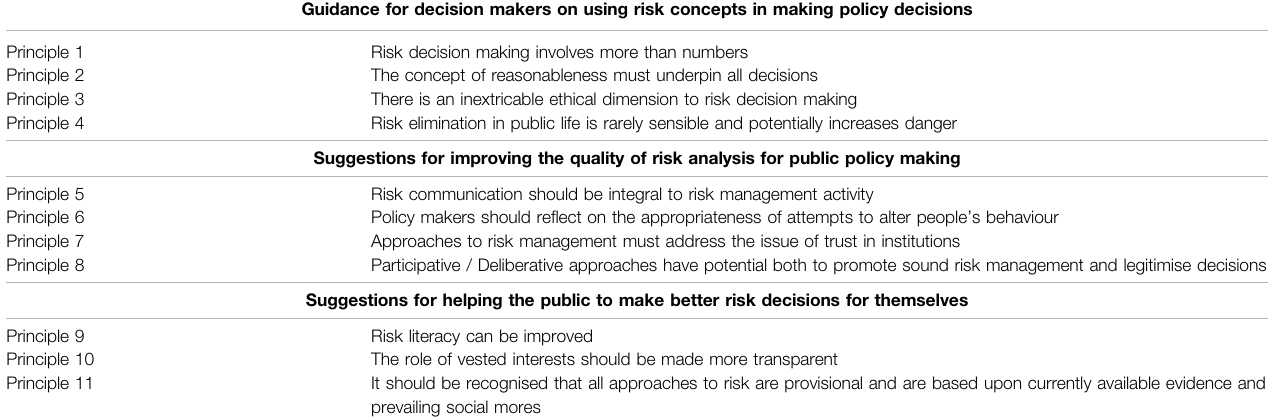
TABLE 1 | Principles of risk management EISMD